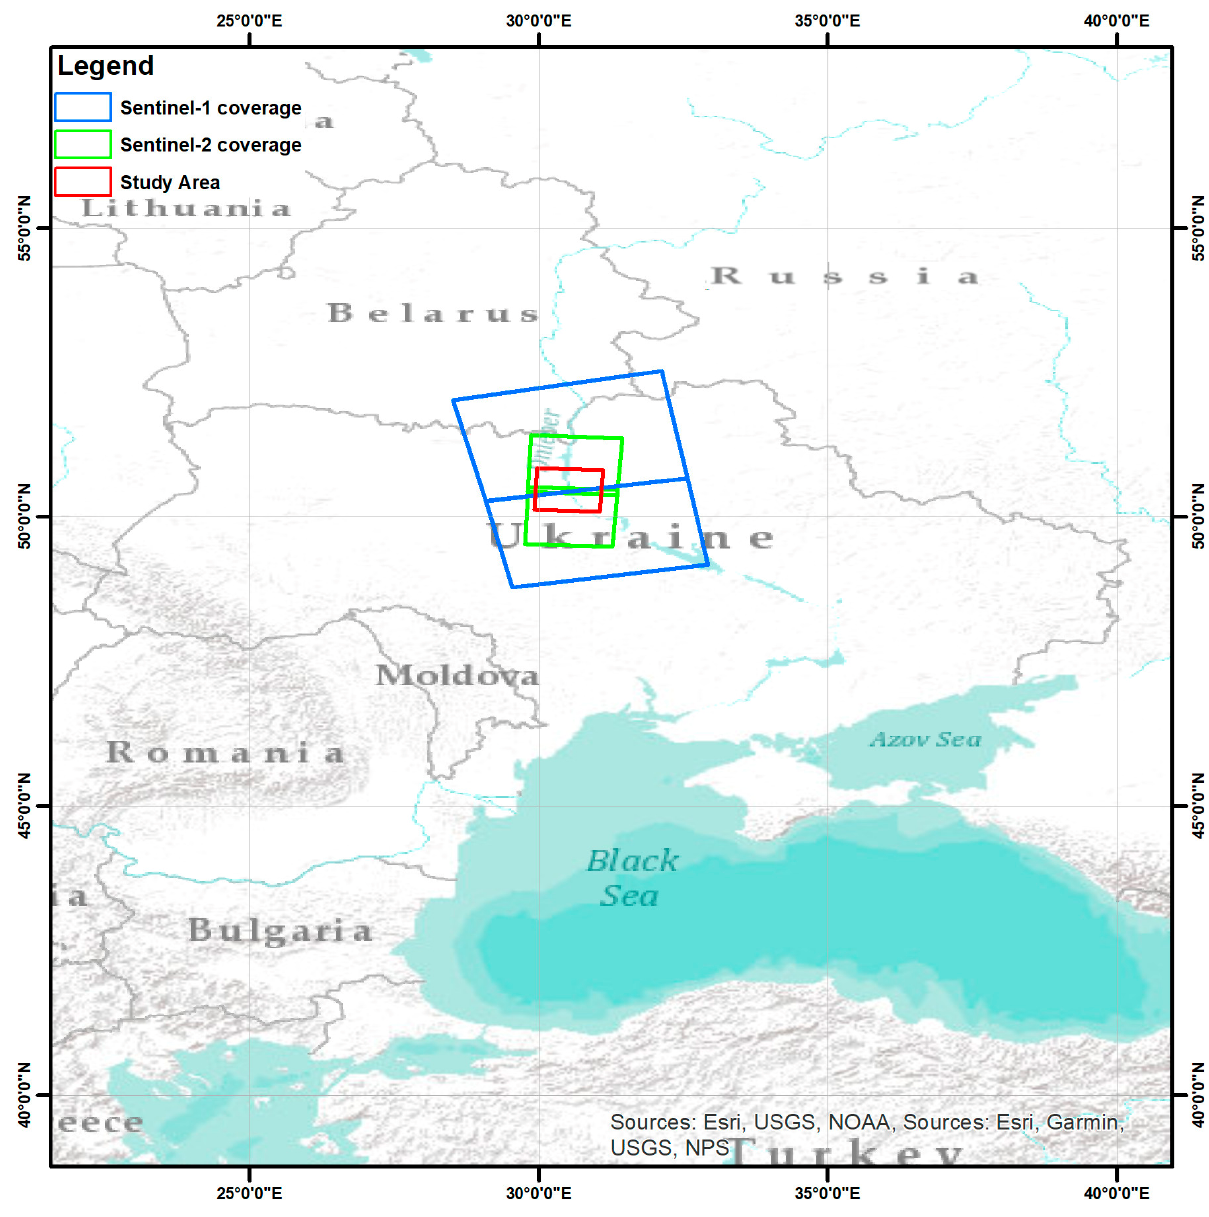
Figure 1. Location of the study area and footprints of the Sentinel-1 and Sentinel-2 images.